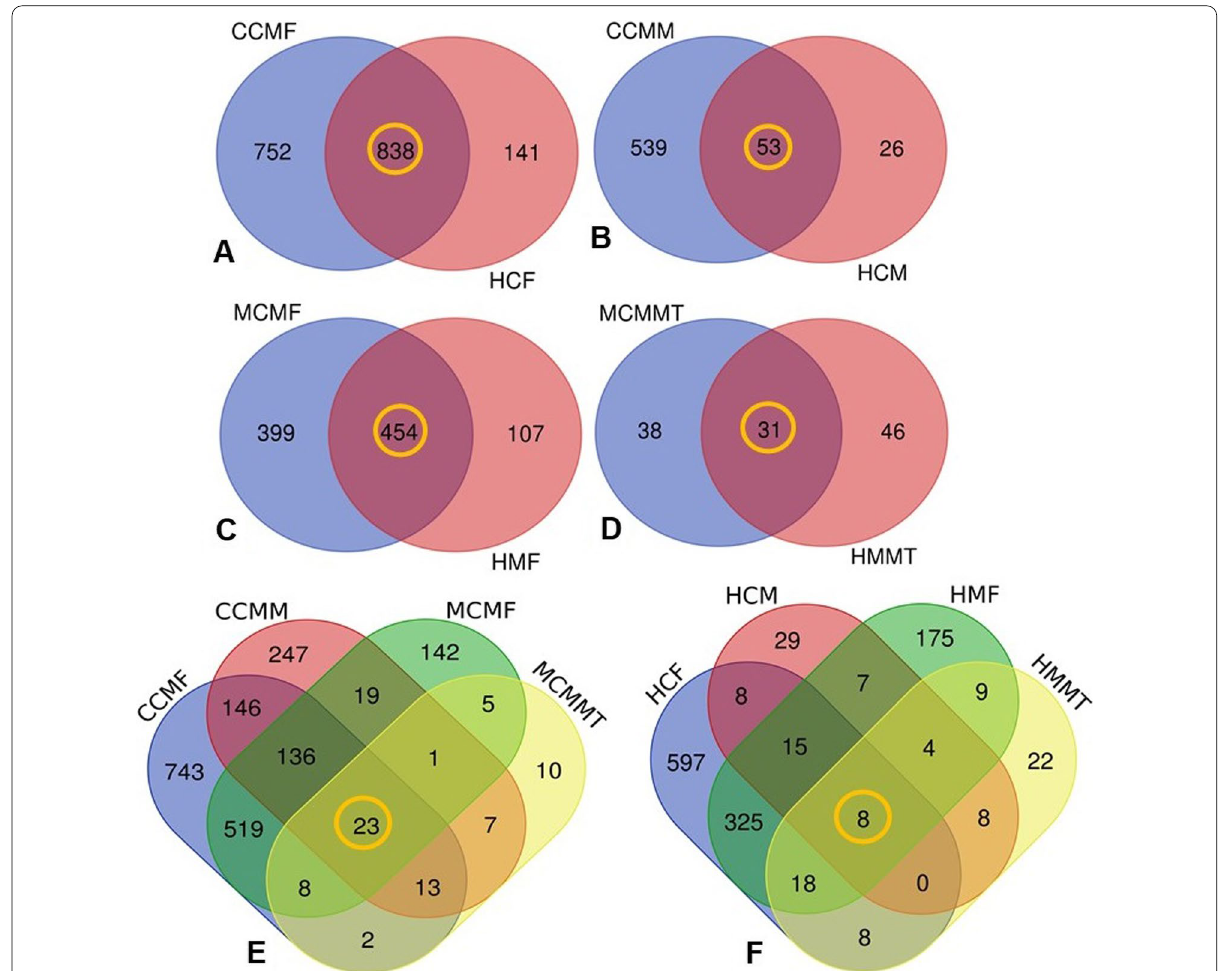
Fig. 3 Taxonomic composition of bacteriomes. Venn diagrams representing the core unique and shared microbiomes in cows faecal material and milk samples, and mouse faecal material and mammary tissues. Bacterial species detected in A cows faecal material, B cows milk, C mouse faecal material and D mouse mammary tissues. E Unique and shared bacterial species in CM, and F unique and shared bacterial species in H metagenomes of both cows and mice. Bacterial species shared in cow and mouse mastitis (CCMM, CCMF, MCMF, MCMMT) and healthy (HCM, HCF, HMF, HMMT) metagenomes are highlighted in yellow color circles. More information on the taxonomic result is also available in Additional file